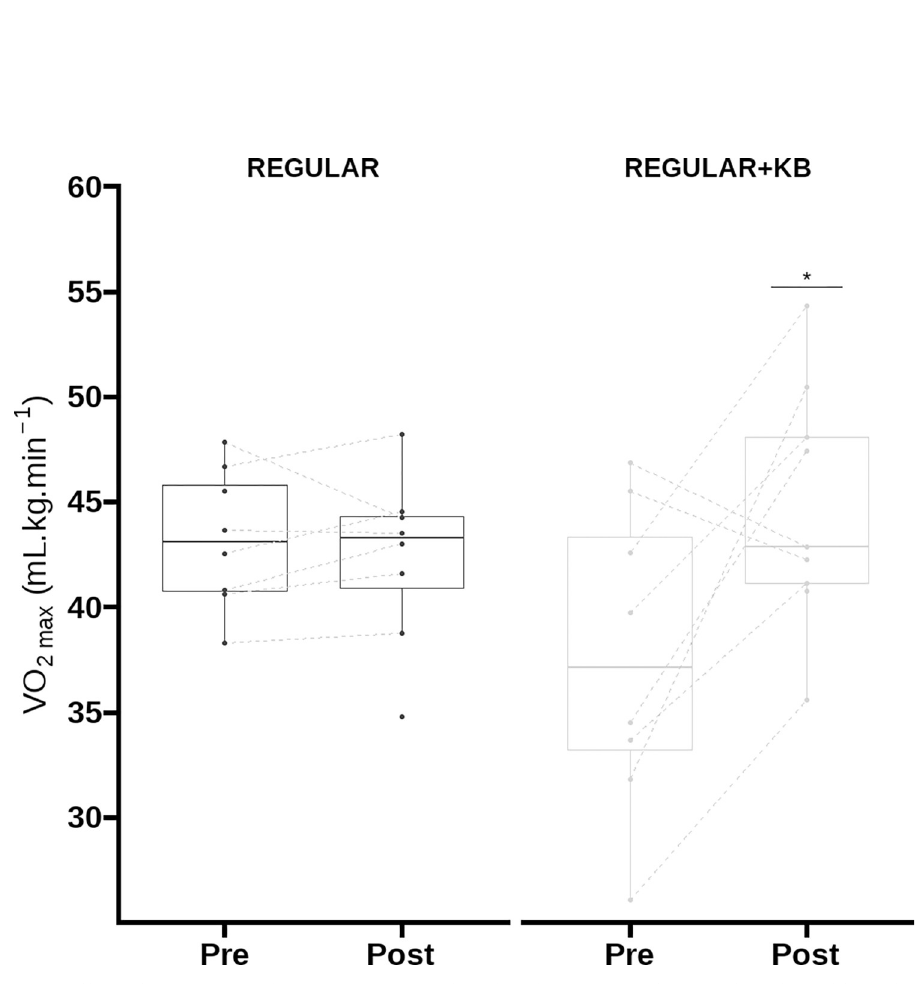
Fig 1. Effects of REGULAR and REGULAR+KB in selected cardiorespiratory fitness indices derived from the cardiopulmonary exercise test. Abbreviations: REGULAR, skill training; REGULAR+KB, regular skill